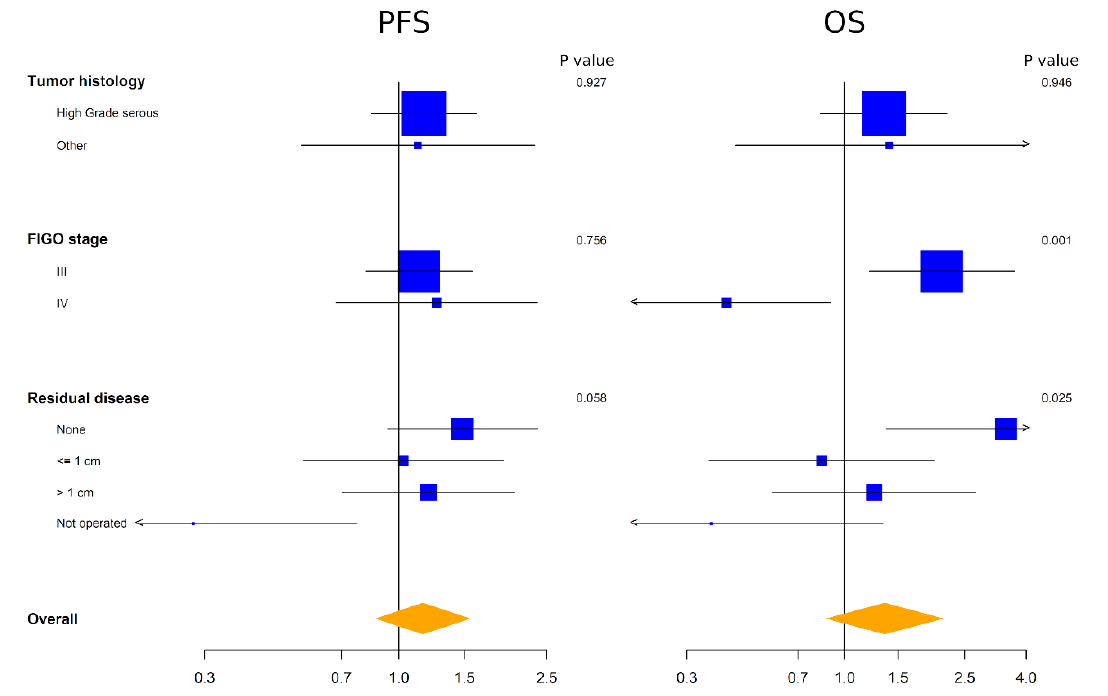
Figure 3. Forest plot representing exploratory subgroup analyses of the effect of ADAM17 expression for PFS ( left ) and OS ( right ). Side numbers are p values and bottom numbers are HR.